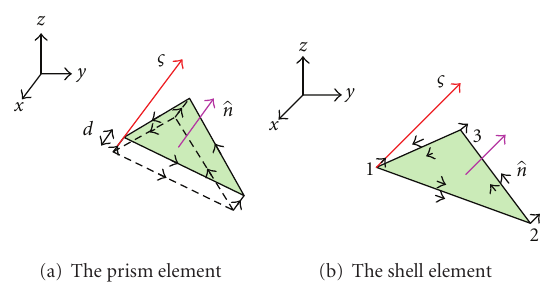
Figure 2: The structure of the prism element and the shell